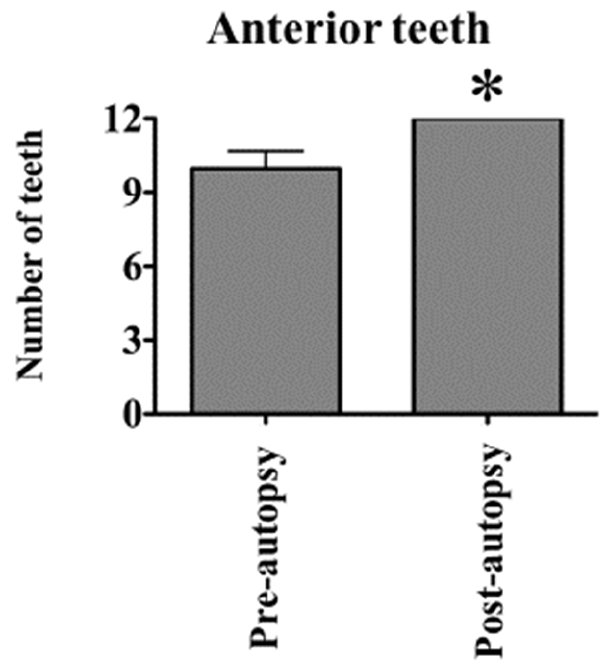
Figure 1. Differences in the number of anterior teeth examined in the pre- and post-autopsy groups. In 30 bodies from which dental findings were obtained before and after autopsy, the number of anterior teeth from which dental findings were obtained is compared between the pre- and post- autopsy groups. The mean number of anterior teeth is 10.0 and 12.0 before and after the autopsy, respectively. The number of anterior teeth is significantly higher in the post-autopsy group than in the pre-autopsy group (* p < 0.05 vs. the pre-autopsy group; n = 30; the values are presented as the mean ± the standard